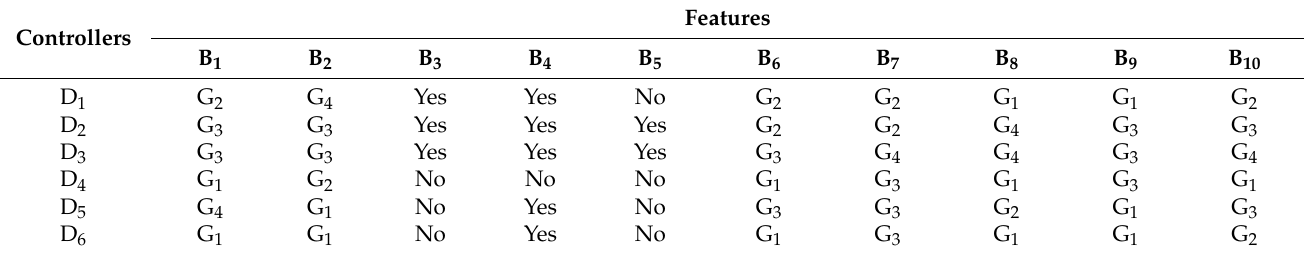
Table 3. Features classification levels in the controllers for